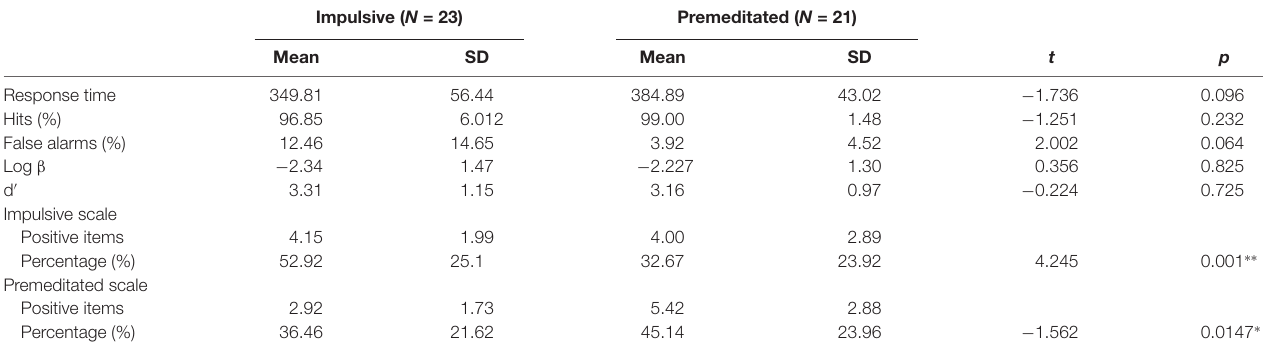
TABLE 1 | Behavioral performance and Impulsive/Premeditated Aggression Scale (IPAS) Scores of impulsive and premeditated